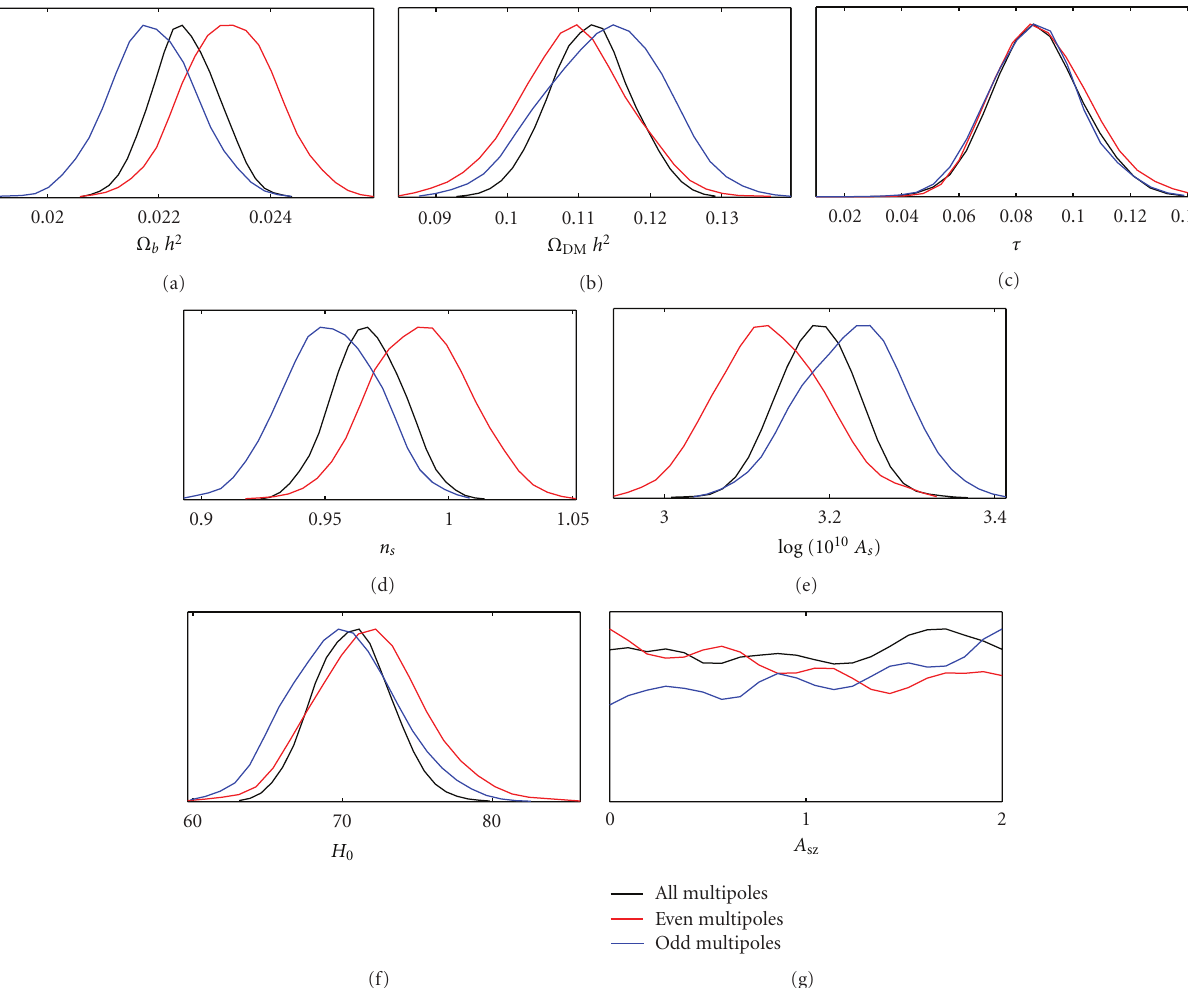
Figure 15: Marginalized likelihood of cosmological parameters ( Λ CDM + sz + lens), given whole or even (odd) multipole data.